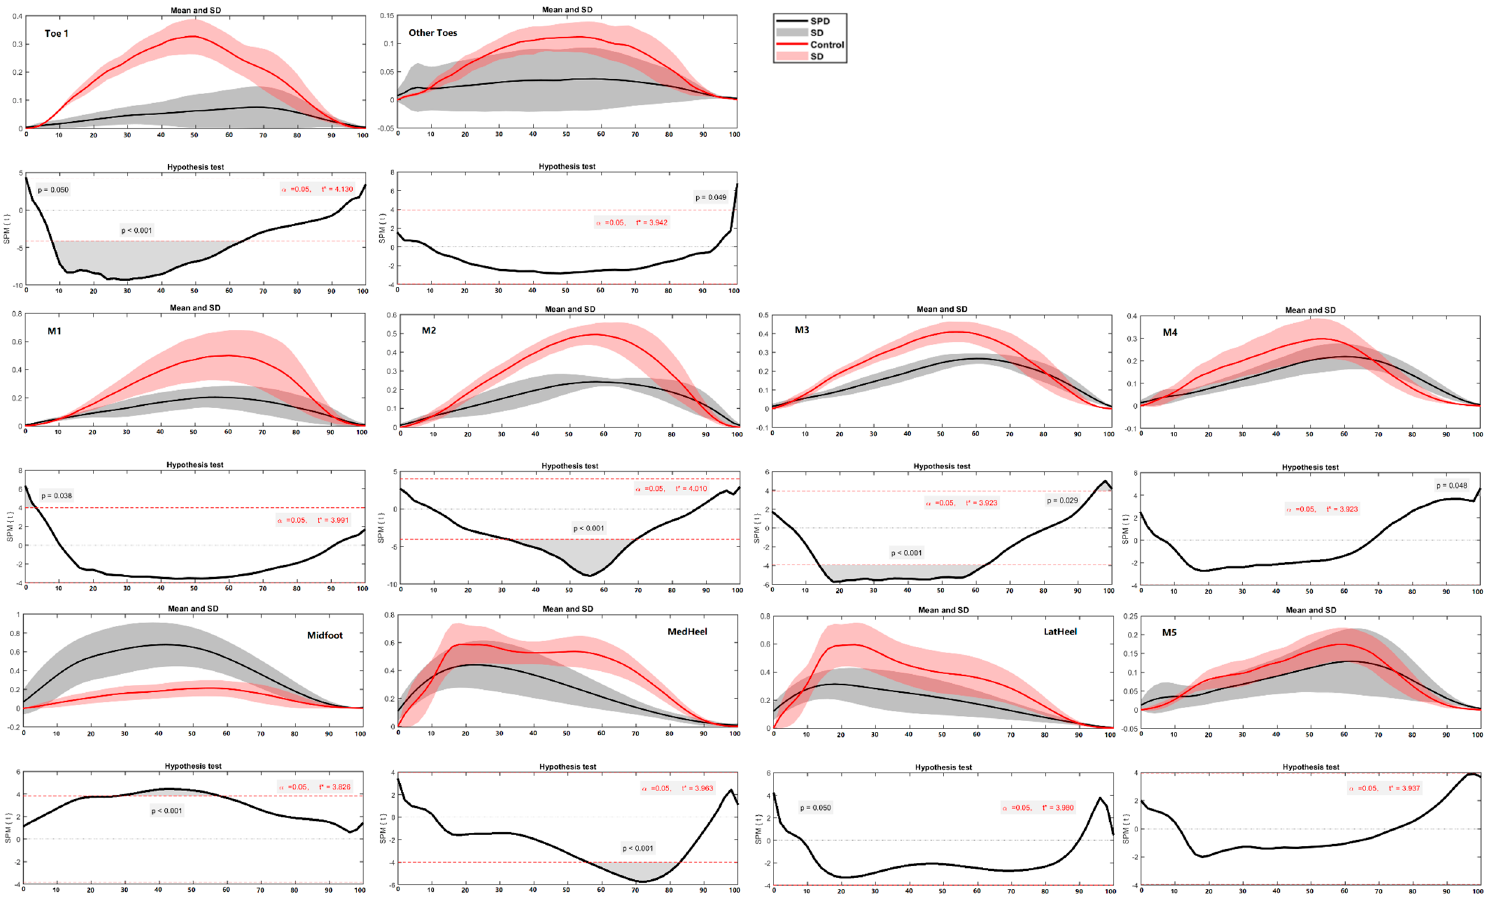
Figure 9. The regional plantar forces in the left foot during running in the SPD children and healthy controls with highlighted statistics.